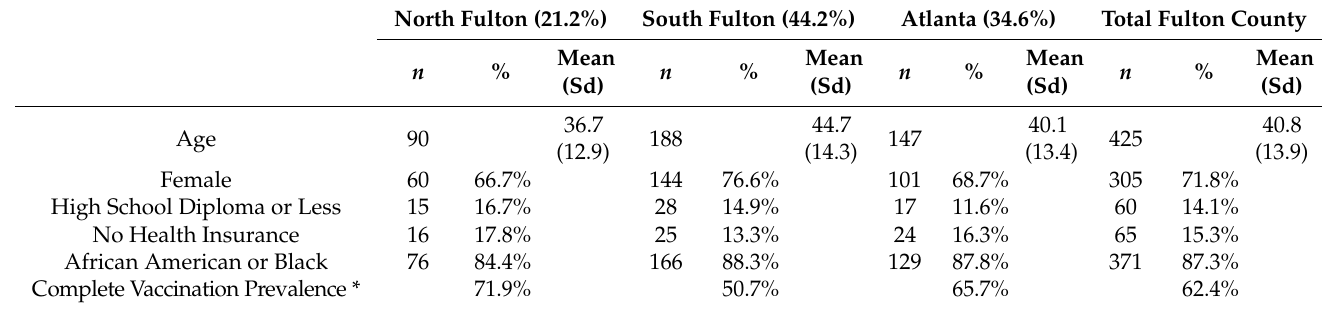
Table 1. Demographics and Vaccination Prevalence by County Area.